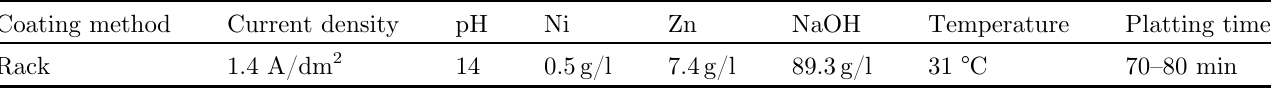
Table 3. Properties of the galvanic process with ZnNi Slotoloy ZN 80 VX electrolyte. Coating